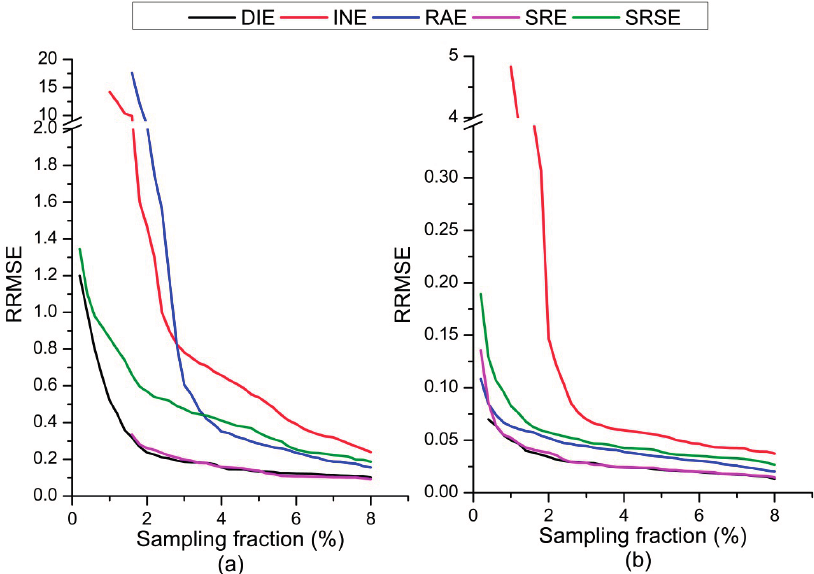
Figure 7. The RRMSE of the area of ( a ) water and ( b ) bare lands in ShunYi districts